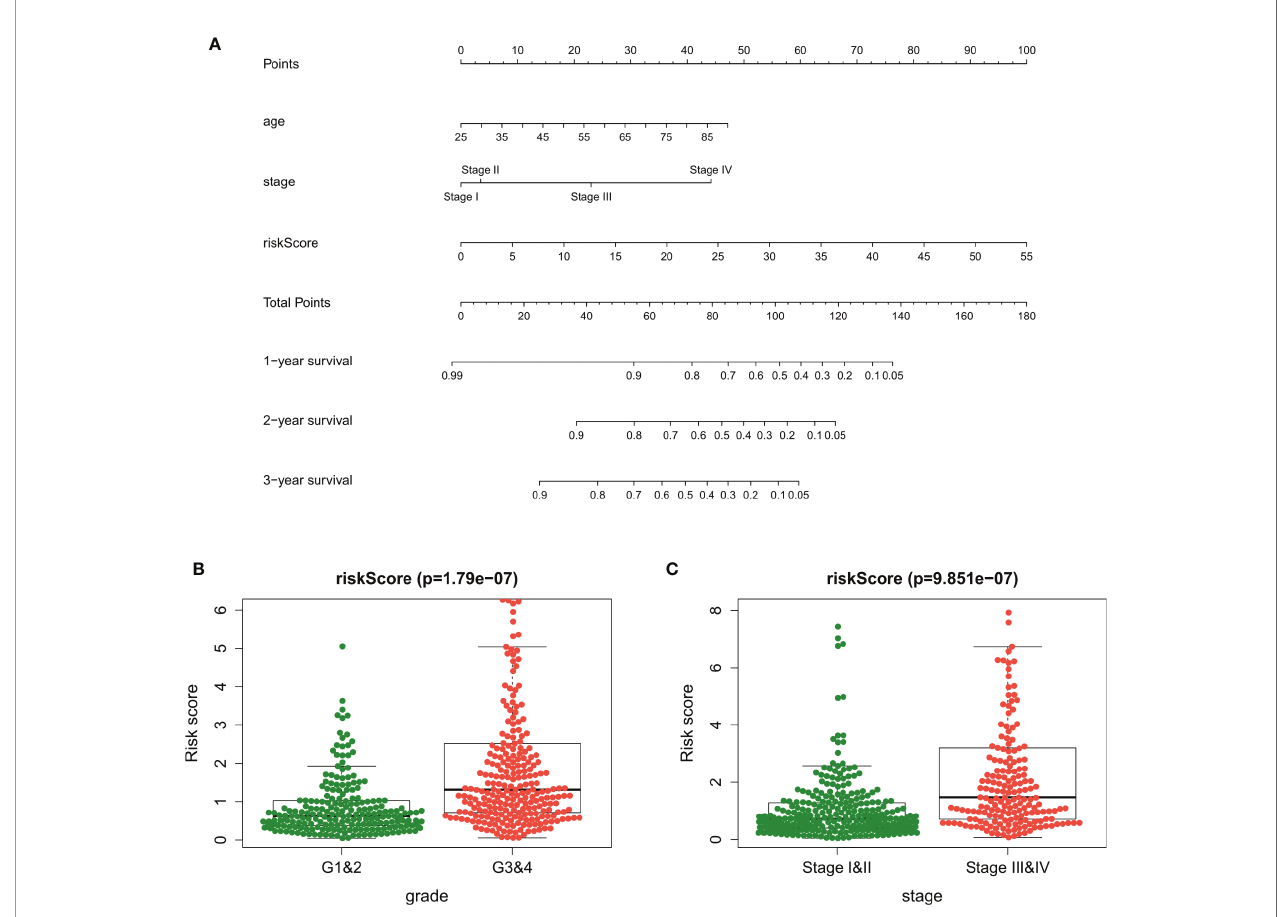
FIGURE 7 | A nomogram plot was established to qualify risk assessment for ccRCC patients (A) . Relationships between the risk score and clinical factors [tumor grade (B) and tumor stage (C) ] in clear cell renal carcinoma.